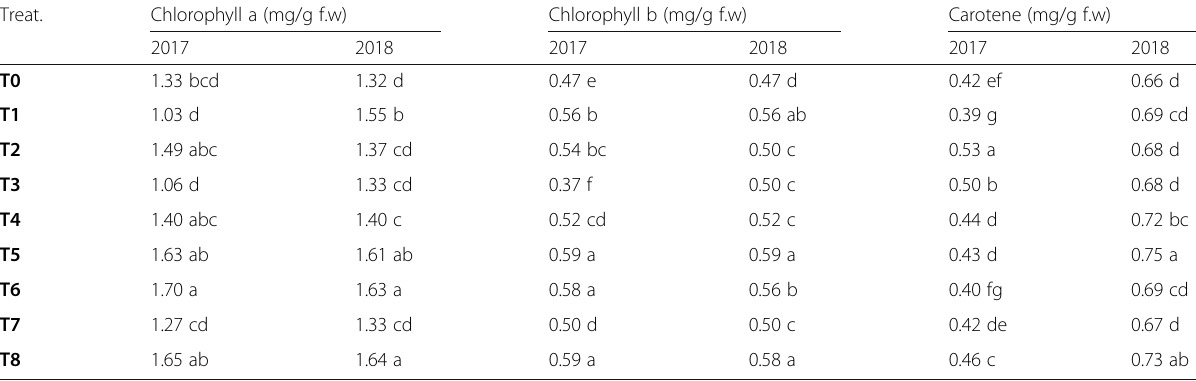
Table 3 Effect of foliar application of B 2 O 3 and ZnO nanoparticles on leaf pigments of Picual cultivar in 2017 and 2018 seasons Treat. Chlorophyll a (mg/g